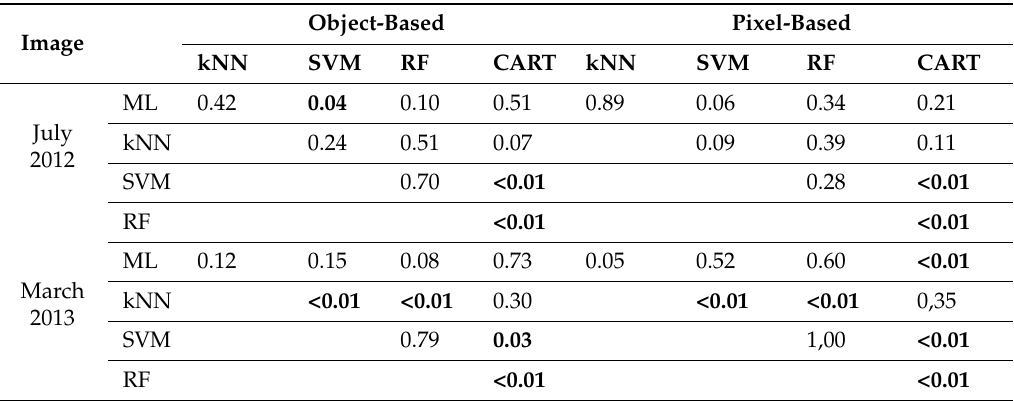
Table 6. McNemar test results ( p -values) for pair-wise comparison between classifiers (bold if significantly different, using α = 0.05).